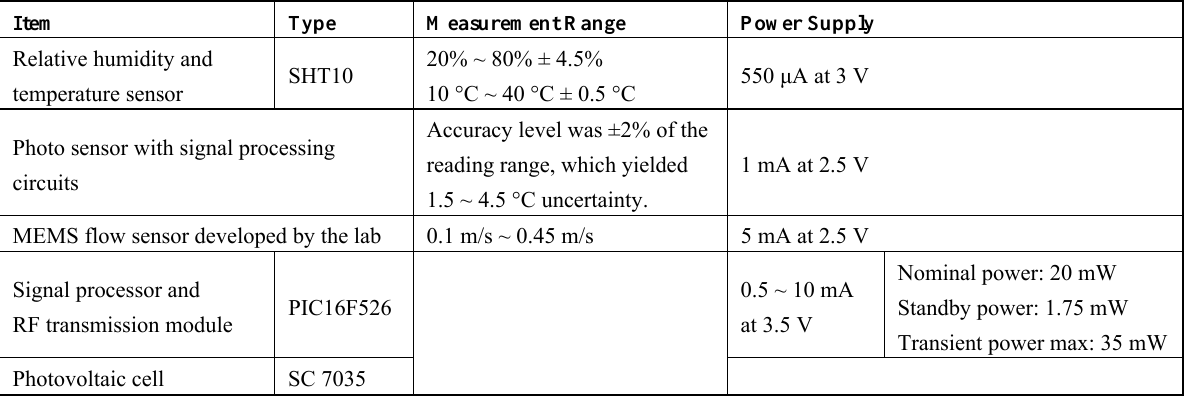
Table 2. Wireless sensor node model and operating